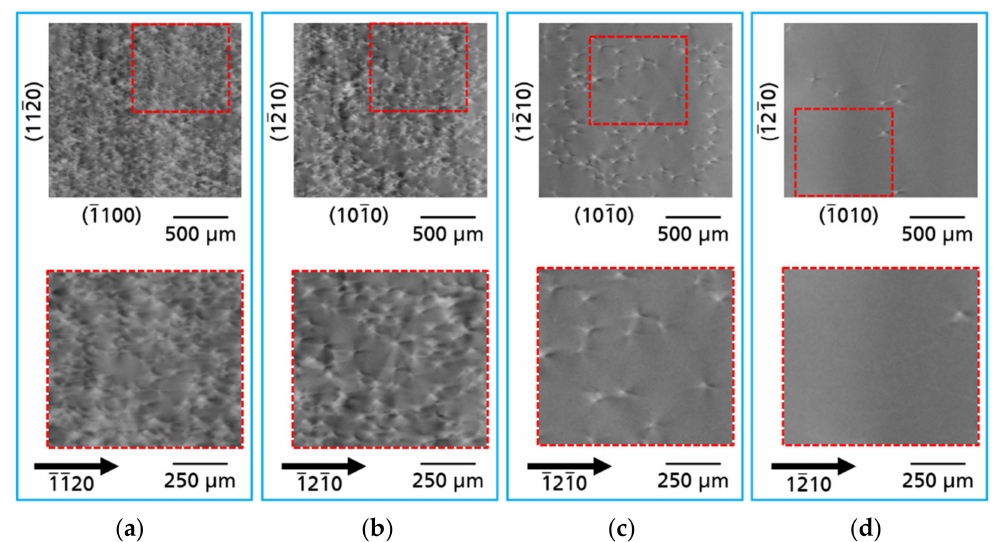
Figure 5. Four areas of threading dislocations in investigated Am-GaN substrates with different TDD: ( a ) high TDD: ~5 × 10 5 cm − 2 ; ( b ) medium TDD: 2 × 10 5 cm − 2 ; ( c ) low TDD: 4 × 10 4 cm − 2 and ( d ) ultra-low TDD: 3 × 10 3 cm − 2 . For the imaging of the topographs type 1120 reflections were